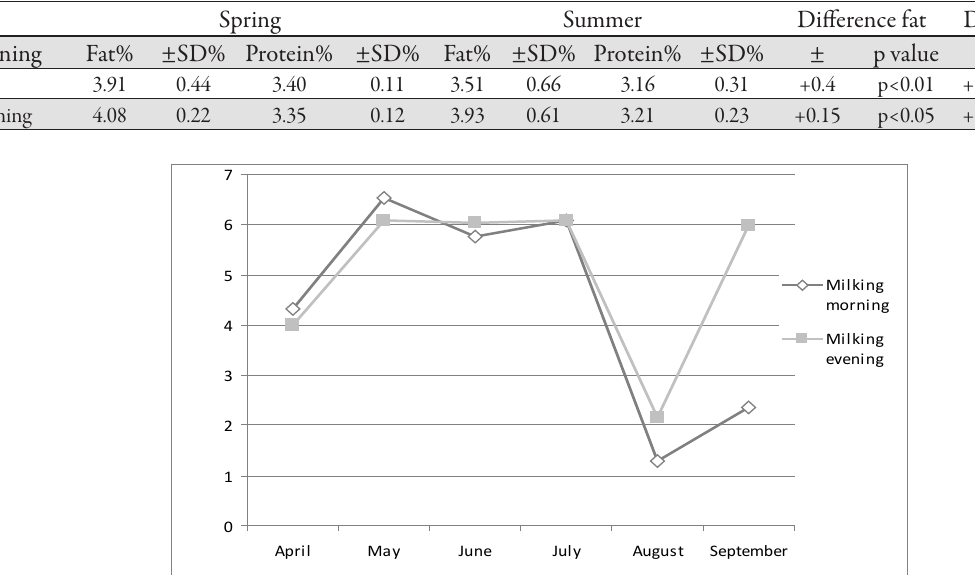
Fig. 1. The number of somatic cells (×100 000/ml) in raw